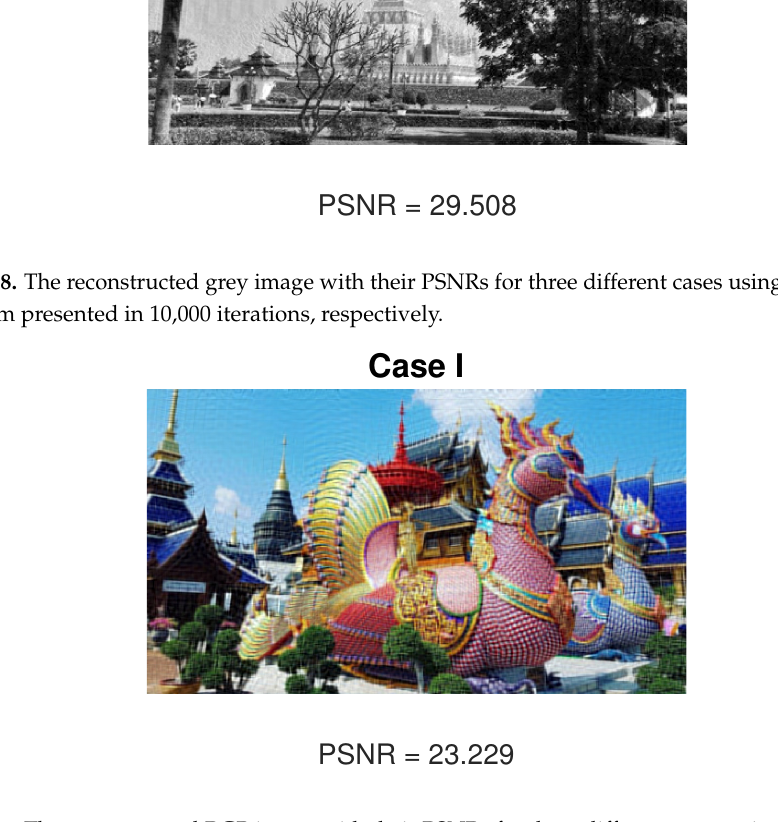
Figure 19. The reconstructed RGB image with their PSNRs for three different cases using the proposed algorithm presented in 10,000 iterations,